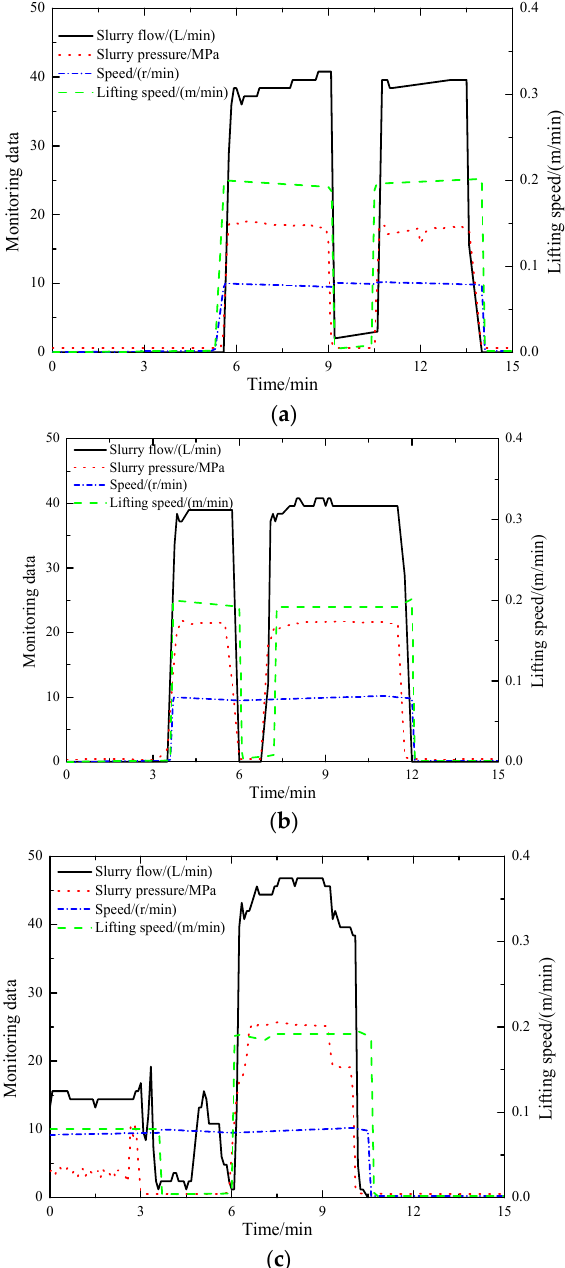
Figure 16. Information monitoring data during construction of test columns. ( a ) HPCG. ( b ) RPCG. ( c ) MKC. ( c )